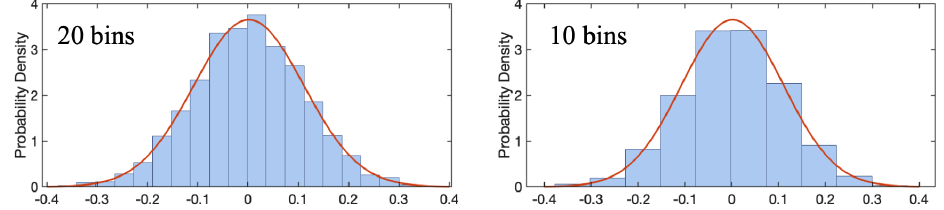
Figure A2. Normalized histogram of particle positions. The code used to generate these plots can be found in